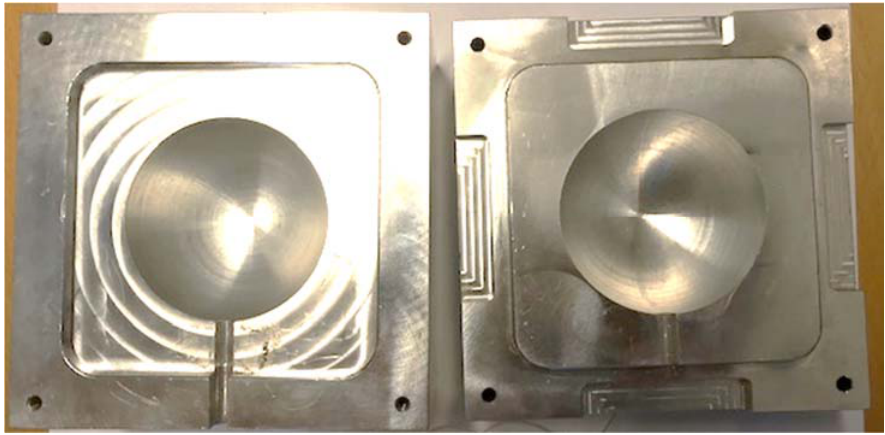
Figure 8. Aluminum processing mold.